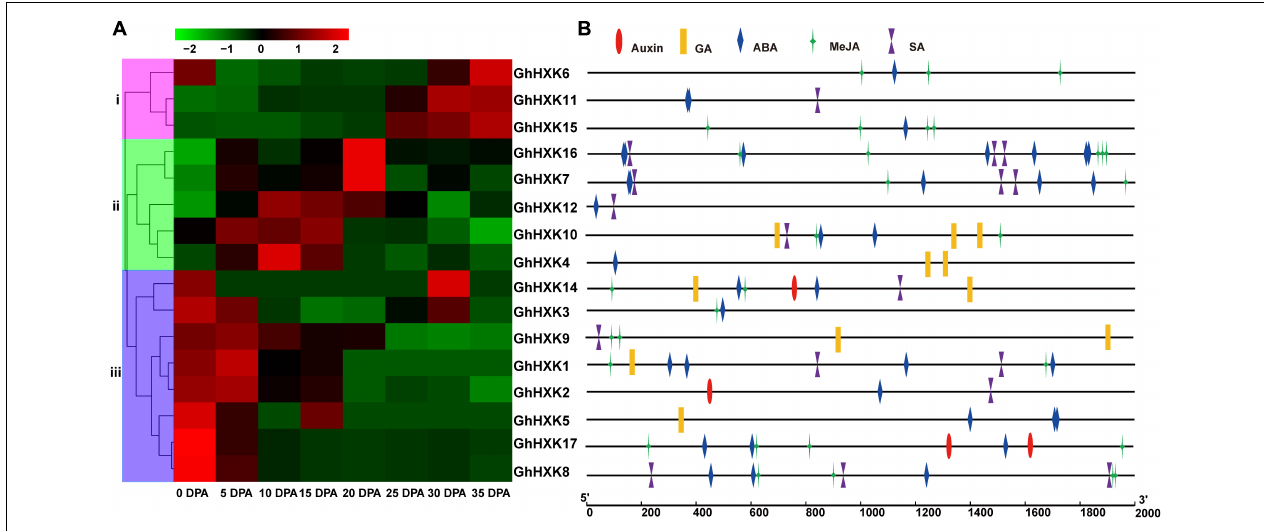
FIGURE 8 | RNA-seq analysis of GhHXKs genes during fiber development at 0, 5, 10, 15, 20, 25, 30 and 35 DPA (A) , and plant hormone-related cis -elements in the GhHXK promoter regions (B) . The transcriptome data were normalized by fragments per kilobase of transcript per million mapped reads (FPKM) and visualized using the pheatmap software (https://www.omicshare.com/tools/Home/Soft/heatmap). The colorful bars from green to red indicate the expression levels from low to high,